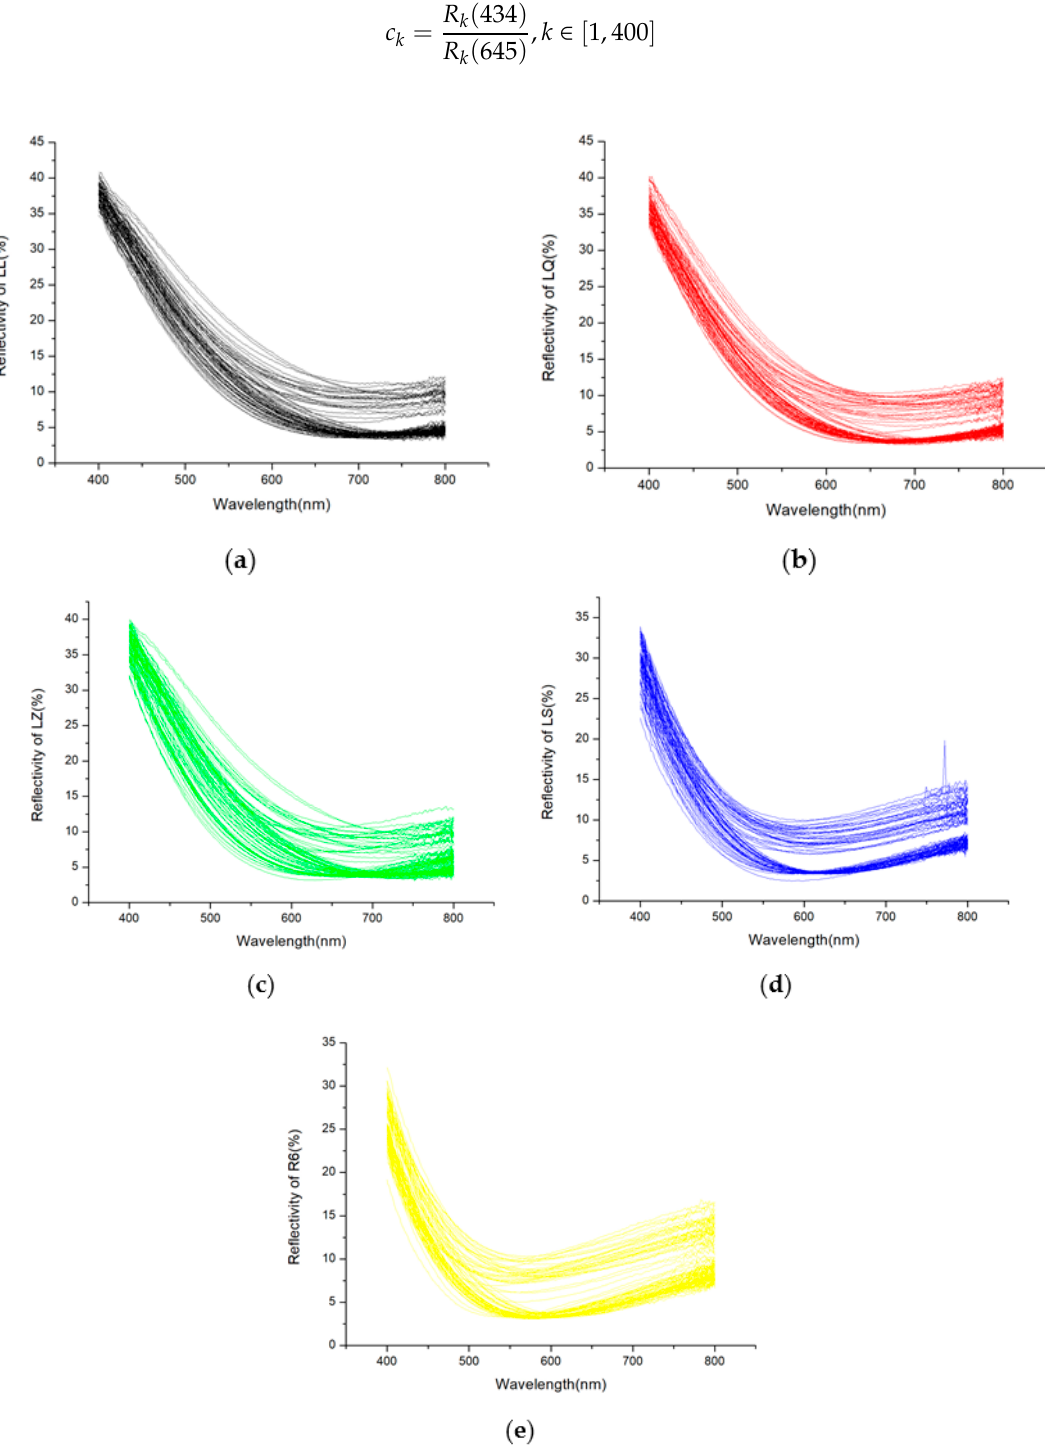
Figure 2. The reflection spectra of Polycrystalline silicon cells of di ff erent color categories, from ( a ) to ( e ) correspond to LL, LQ, LZ, LS,